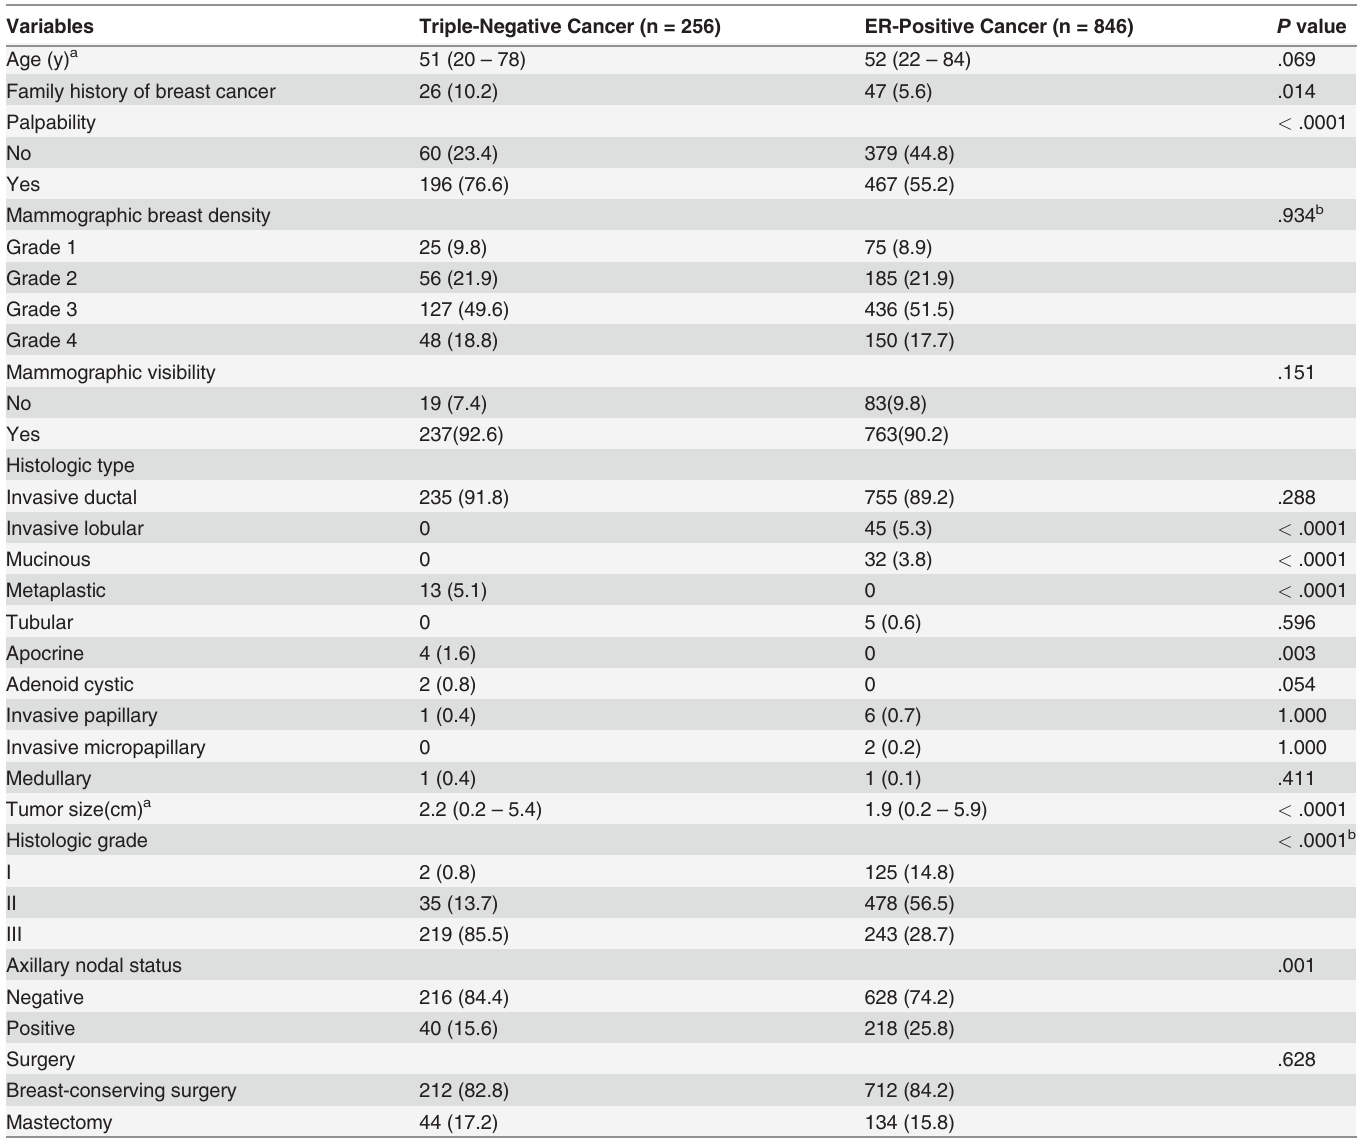
Table 1. Clinicopathologic Characteristics.